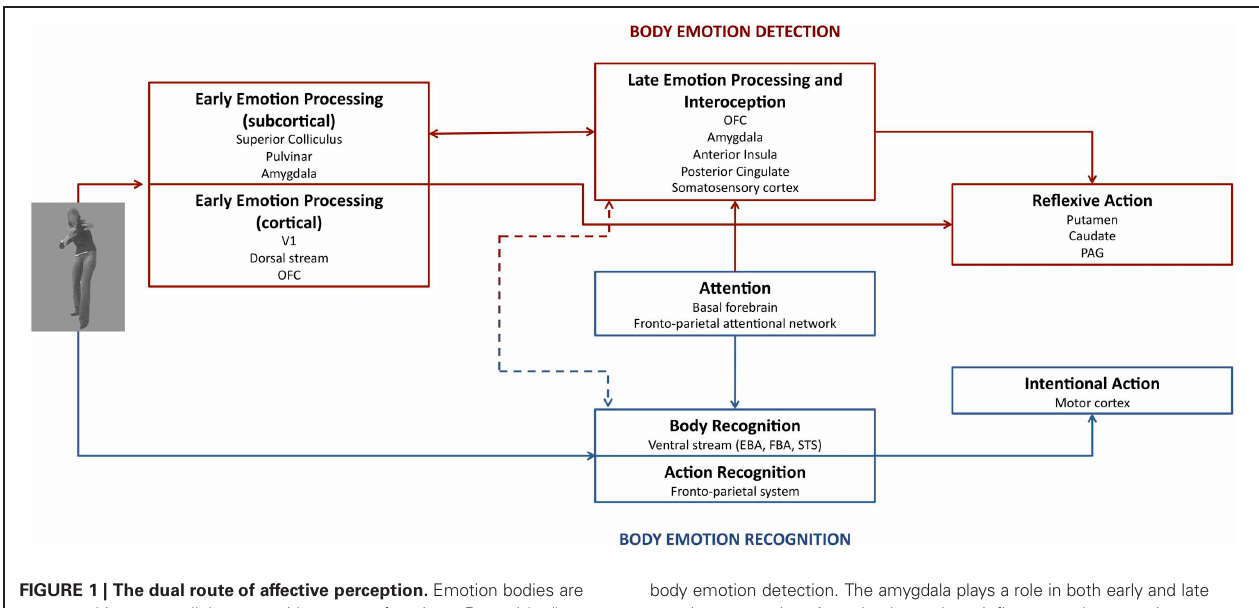
FIGURE 1 | The dual route of affective perception. Emotion bodies are processed in two parallel routes with separate functions. Route I (red) underlies body emotion detection, whereas route II (blue) is important for